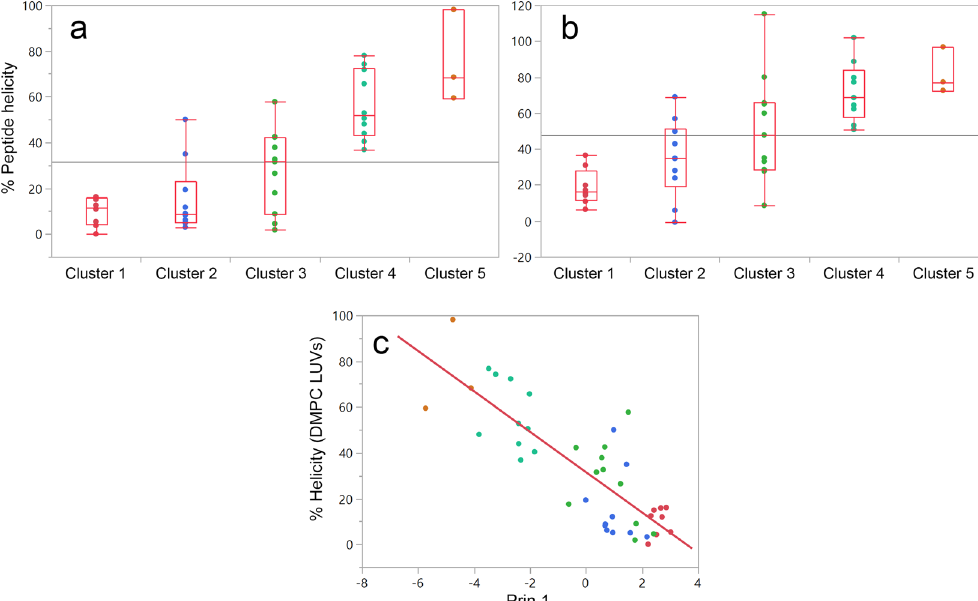
Figure 5. Peptide perturbations of model membranes are correlated to median percent helicity at 2 mol% peptide in DMPC and 2:1 DMPC:DMPG LUVs. Molar ellipticity of peptides at 222 nm was used to calculate peptide percent helicity in buffer and after the addition of LUVs at the specified molar ratio according to the method of Chen et al . 17 . A table was compiled (Supplementary material 03) and the median helicity of peptides after the addition of ( a ) DMPC and ( b ) 2:1 DMPC:DMPG LUVs was calculated as a function of cluster identity. ( c ) The relative position of peptides along the first principal component in PCA2 is linearly correlated to their percent helicity at 2 mol% in DMPC LUVs. The Pearson correlation between the relative position of peptides at Prin1 and their percent helicity when titrated with DMPC LUVs was r 2 = 0.67, ANOVA p < 0.0001). Regression equation: Helicity (%) = 31 ( ± 2) - 9 ( ± 1) × Prin1. Peptide clusters are color coded: Cluster 1, in red, cluster 2 in blue, cluster 3 in green, cluster 4 in green and cluster 5 in gold.